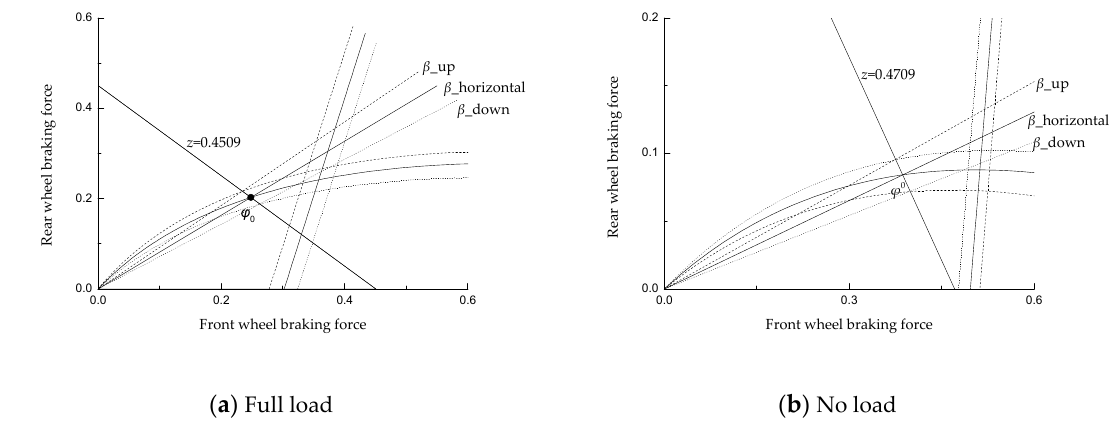
Figure 7. β line and I curve & f line. ( a ) Full load; ( b ) no load.